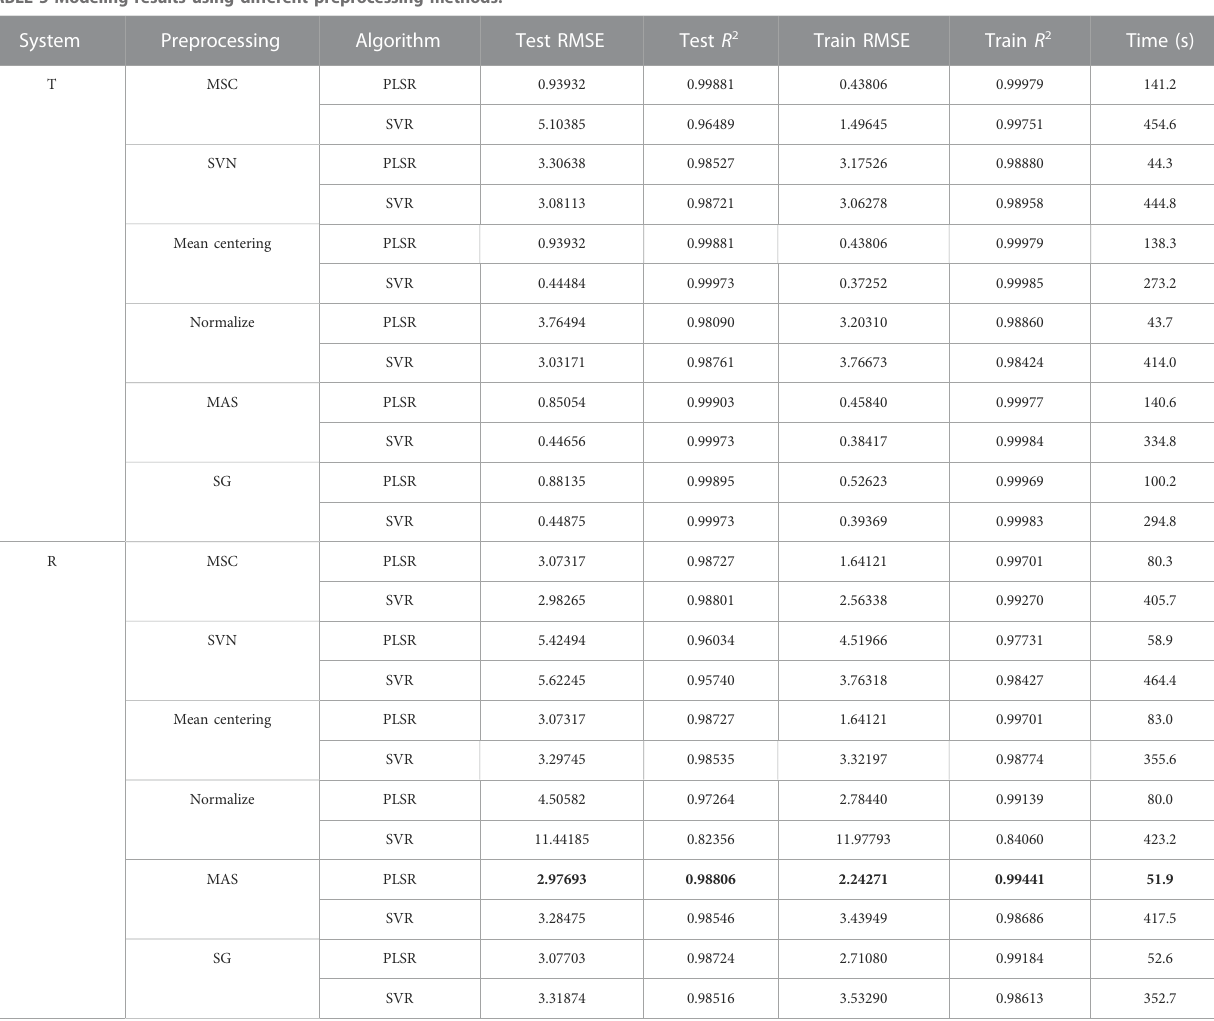
TABLE 5 Modeling results using different preprocessing